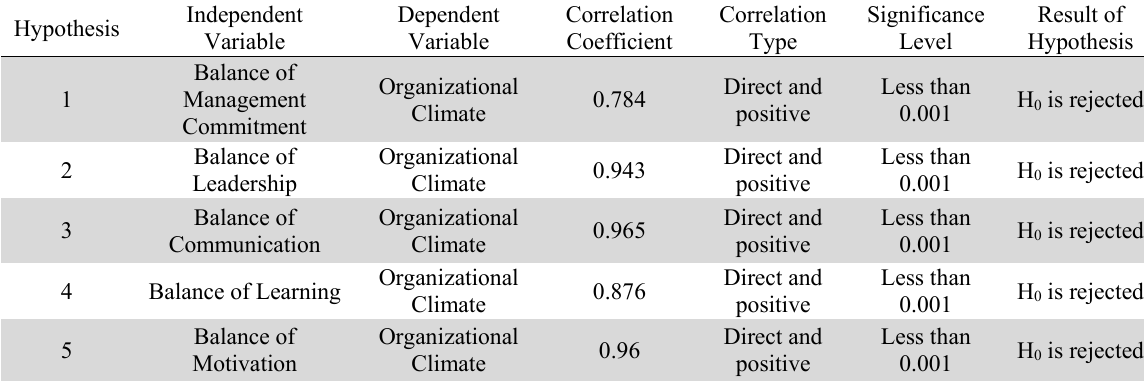
Research findings